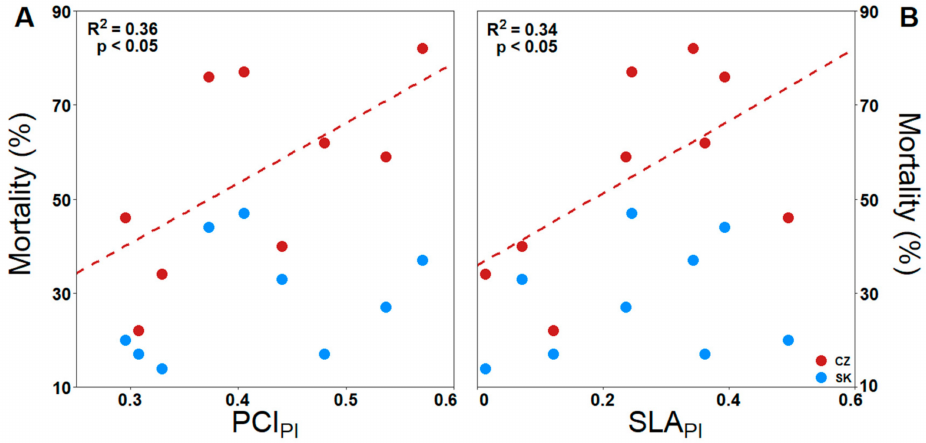
Figure 6. Visualization of the relationship between plasticity indices ( PCI PI , ( A ); SLA PI , ( B )) and the observed mortality of provenances in the Czech (red) and Slovak (blue) provenance plot. The linear regression was significant only for drier Czech provenance